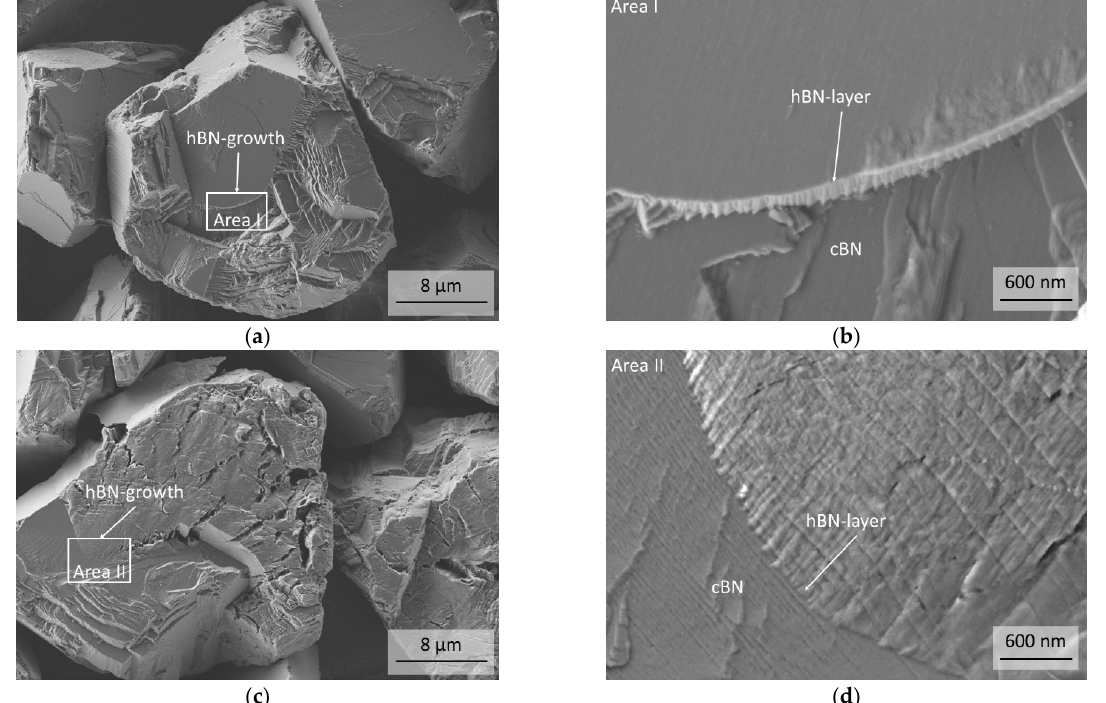
Figure 9. ( a , b ) FESEM micrographs of a particle of the under argon tempered C41 and ( c , d ) B21 powder with different magnifications.